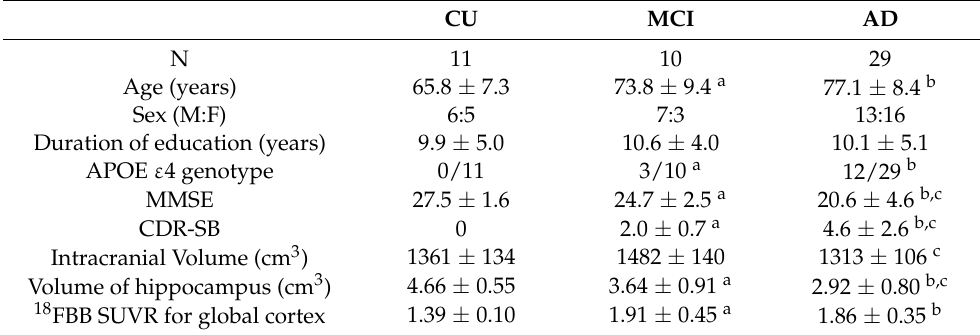
Table 1. Baseline demographic